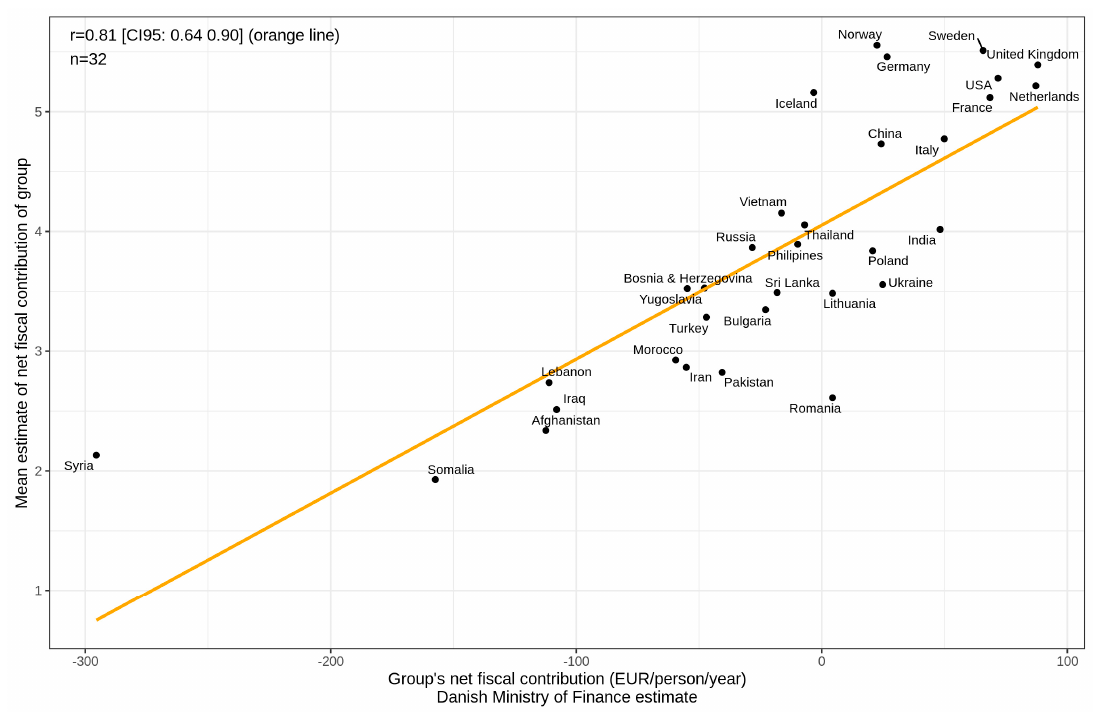
Figure 1. Aggregate stereotype accuracy (Pearson r). Y-axis values are group’s estimated net fiscal